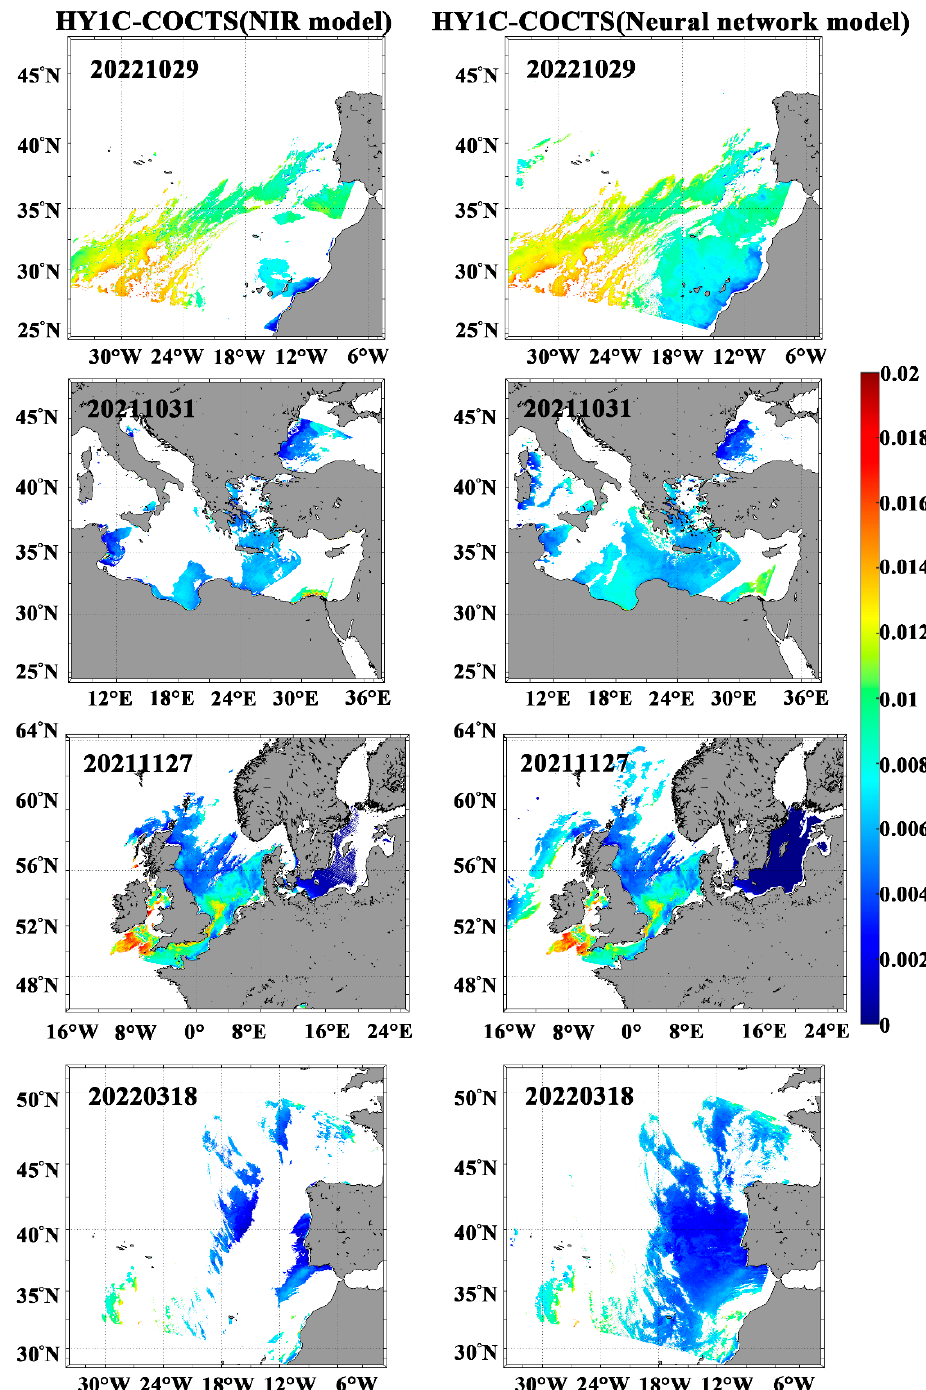
Figure 9 . Rrs (443 nm) products from HY-1C-COCTS processed by the neural network atmospheric correction algorithm and NIR iterative atmospheric correction algorithm. correction algorithm and NIR iterative atmospheric correction